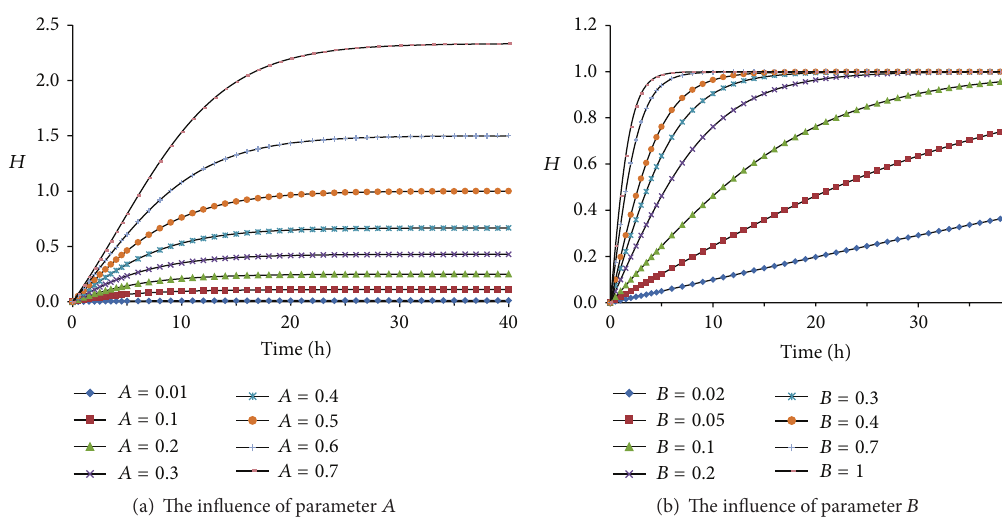
Figure 4: The influence of parameters 𝐴 and 𝐵 on hardening